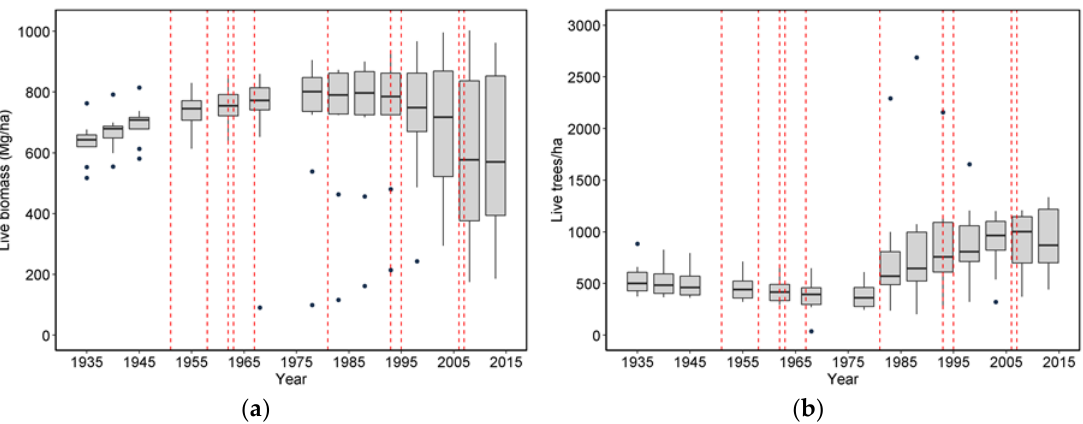
Figure 7. Median and range of live bole biomass (Mg) per hectare ( a ) and number of trees per hectare ( b ) across ten permanent plots at Cascade Head Experimental Forest, Otis, OR, USA. Values for 1962 are interpolated for all stands except CH06 which was reconstructed. The red vertical lines indicate major wind events.